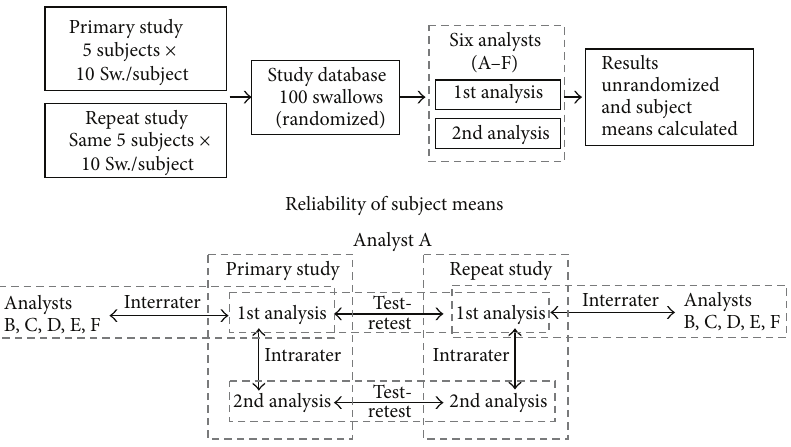
Figure1:Studyoutline.Themasterswallowdatabasecomprisedatotalof100 × 10 mLswallows(10swallows × twomeasurements × 5subjects) recorded in Manoview. Swallows were randomised and then six observers, who received identical training, performed repeat analyses of all swallows. Analyst data sets were then unrandomised and average values for each metric were calculated (i.e., Primary and Repeat Study means for each of the five subjects derived for each of Analyses 1 and 2).